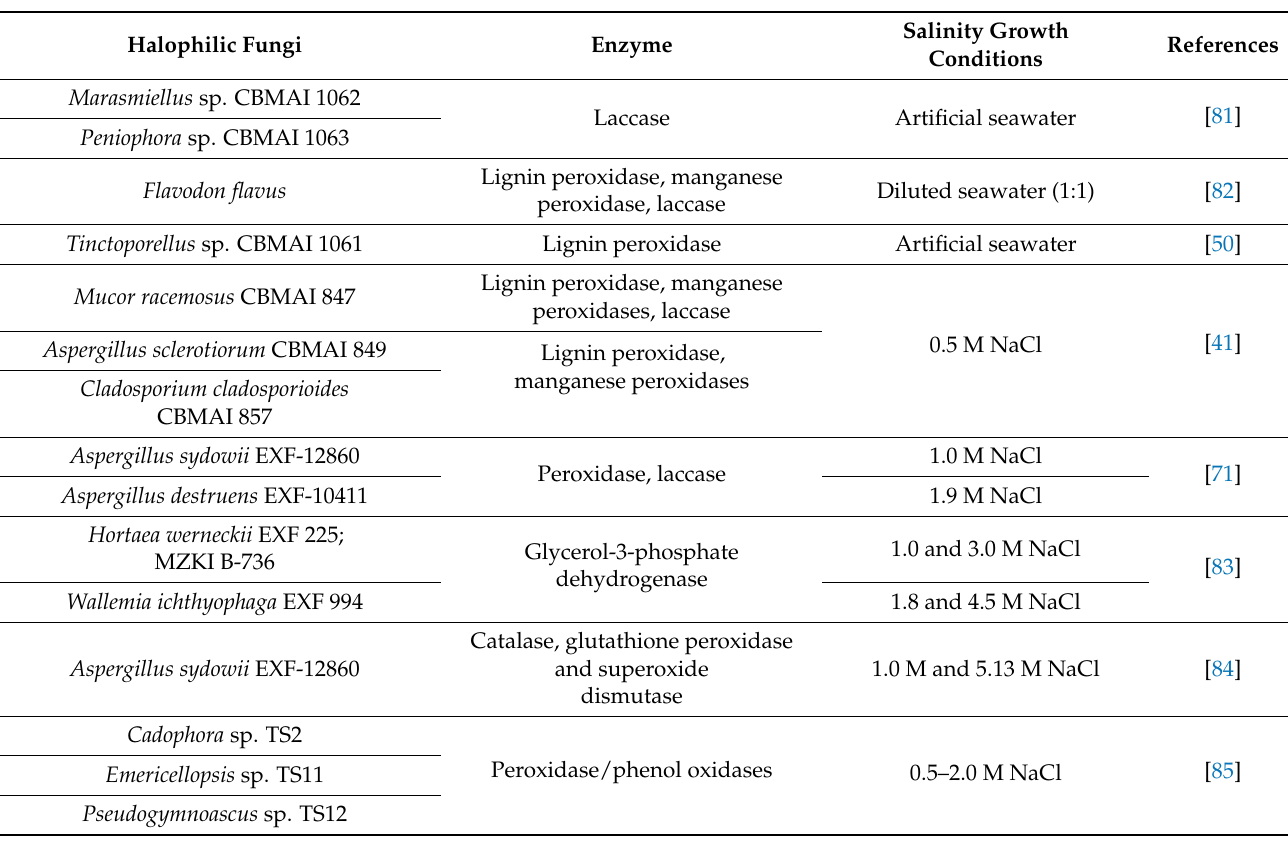
Table 2. Oxidoreductases obtained from halophilic